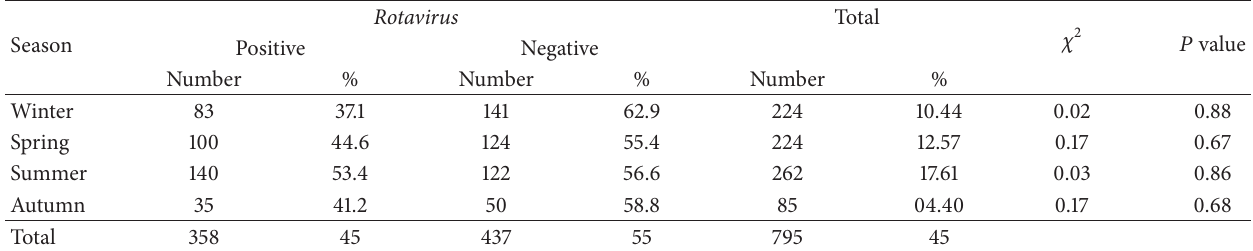
Table 5: Seasonality of Rotavirus diarrhea among children in Taiz, Yemen.